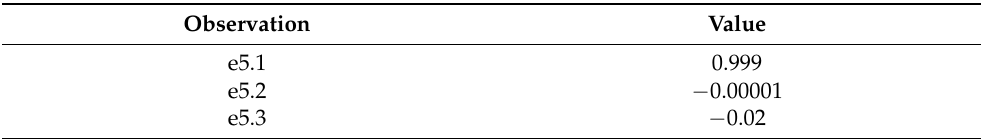
Table 5. Assignment of particular values for h5. Prepared by the authors as an example. Prepared by the authors on the basis of